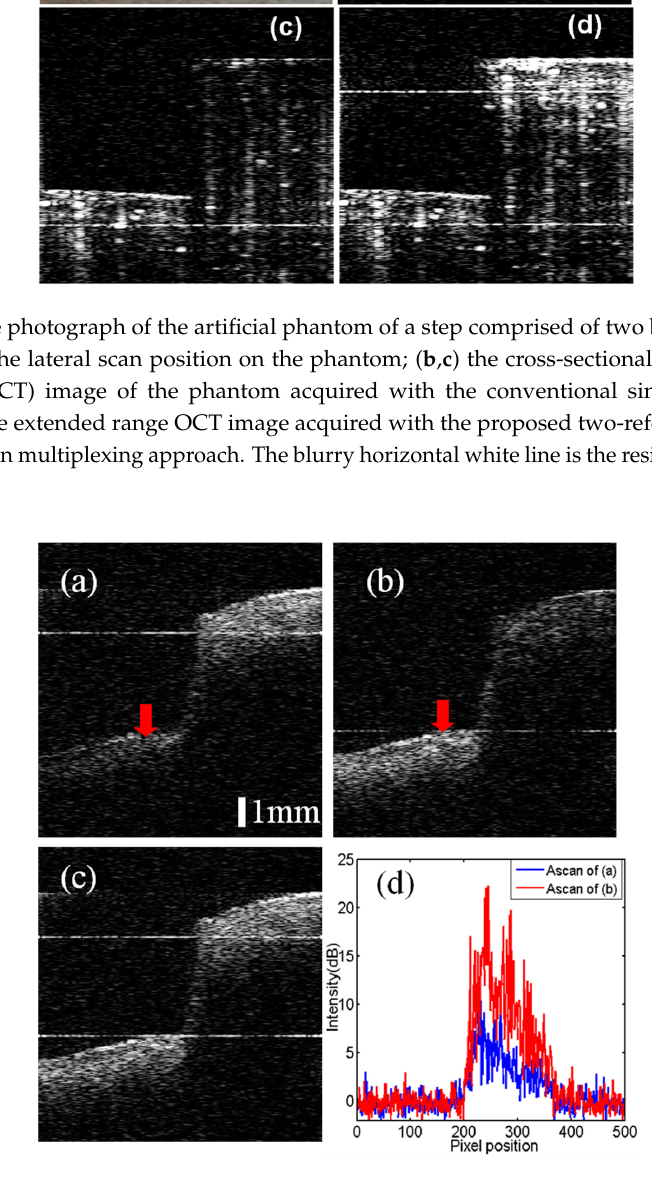
Figure 6. ( a ) The photograph of the artificial phantom of a step comprised of two blocks of sellotape. The red line is the lateral scan position on the phantom;( b , c ) the cross ‐ sectional optical coherence tomography (OCT) image of the phantom acquired with the conventional single ‐ reference ‐ arm approach; ( d ) the extended range OCT image acquired with the proposed two ‐ reference ‐ arm spatial frequency domain multiplexing approach. The blurry horizontal white line is the residual direct current (DC) term.